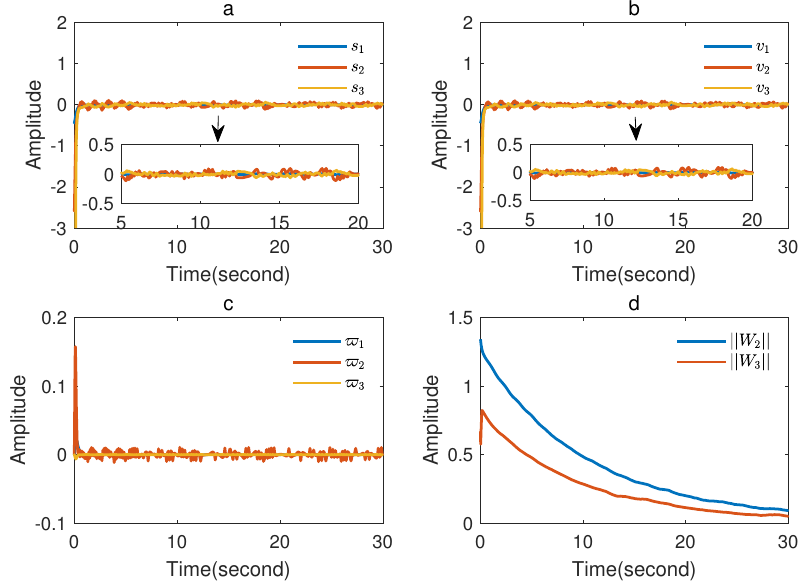
Figure 3. Simulation results. ( a ) Tracking errors. ( b ) Error compensations of command filter. ( c ) Com- pensation signals. ( d ) The vector norms || W i || ( i = 2,3 )